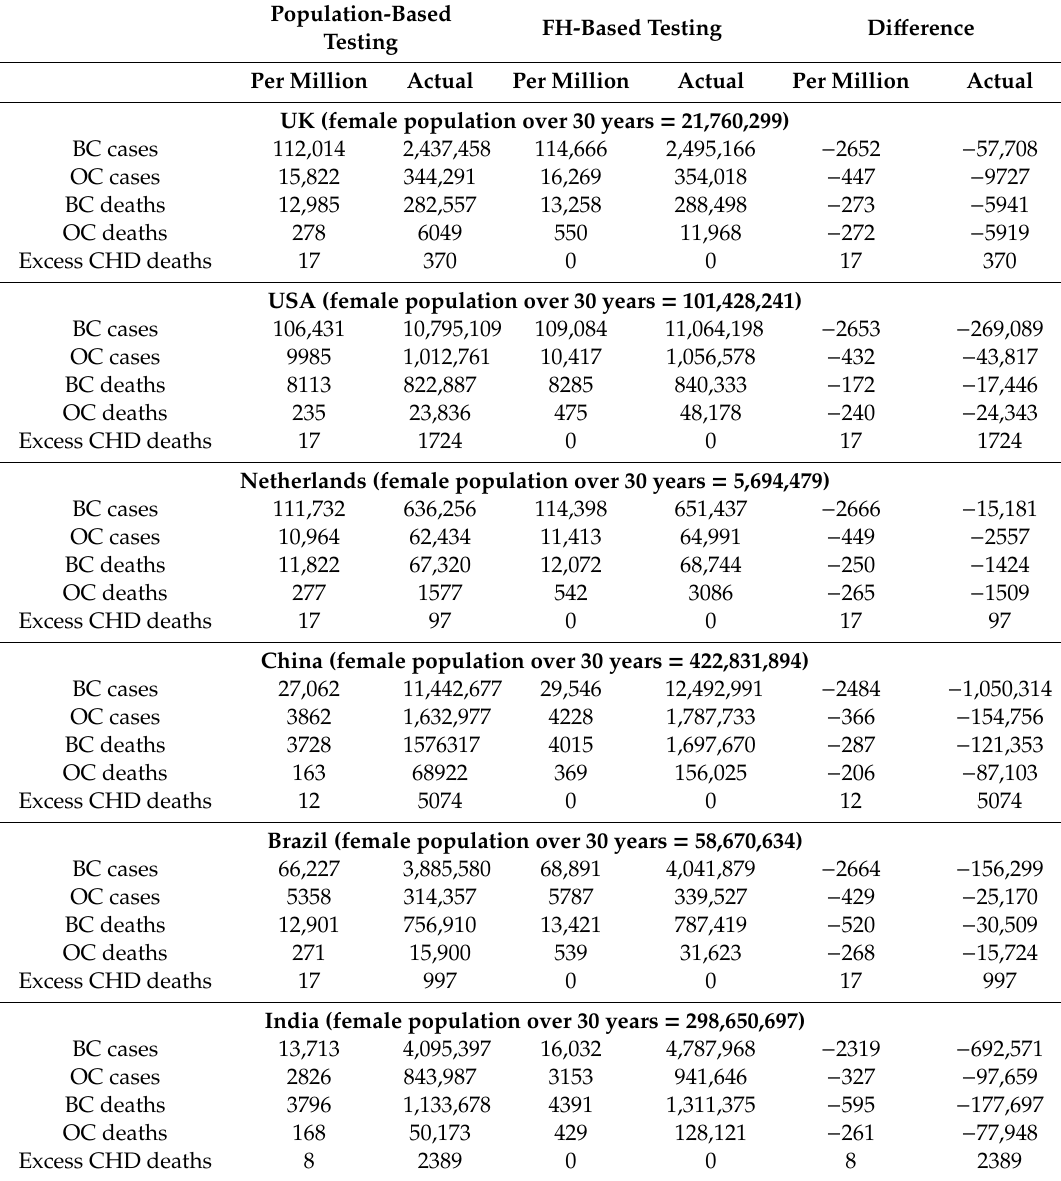
Table 2. Lifetime population impact of o ff ering genetic testing for the population. Population-Based FH-Based Testing Di ff Testing